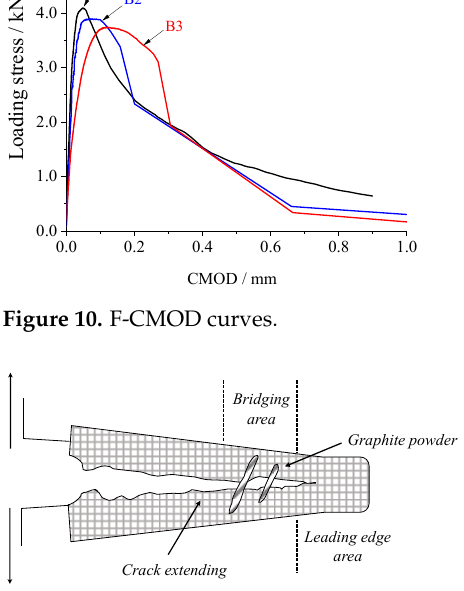
Figure 11. Schematic diagram of the bridging effect.